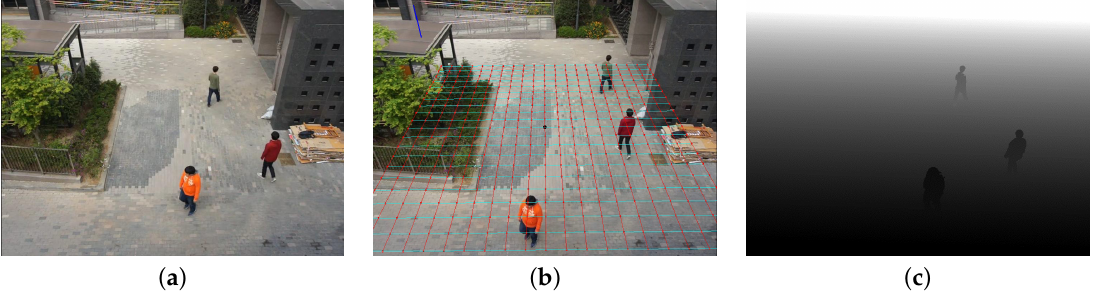
Figure 8. The results of the proposed object depth estimation: ( a ) input image; ( b ) calibration result in the form of the superimposed grid representing the ground plane; and ( c ) the depth estimation